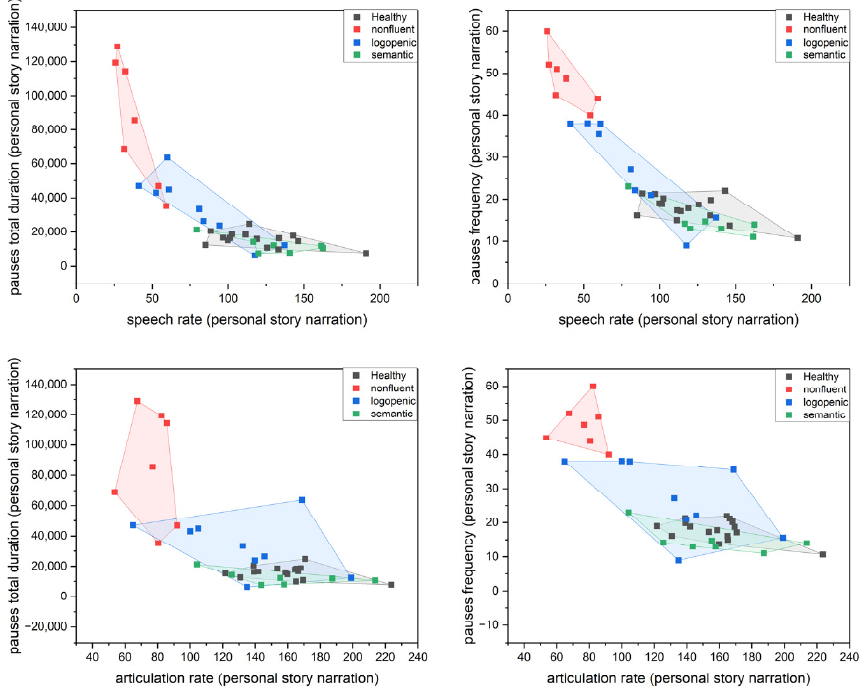
Figure 6. Scatter plots with convex hull ellipse depicting pause attributes versus speech attributes for the personal story